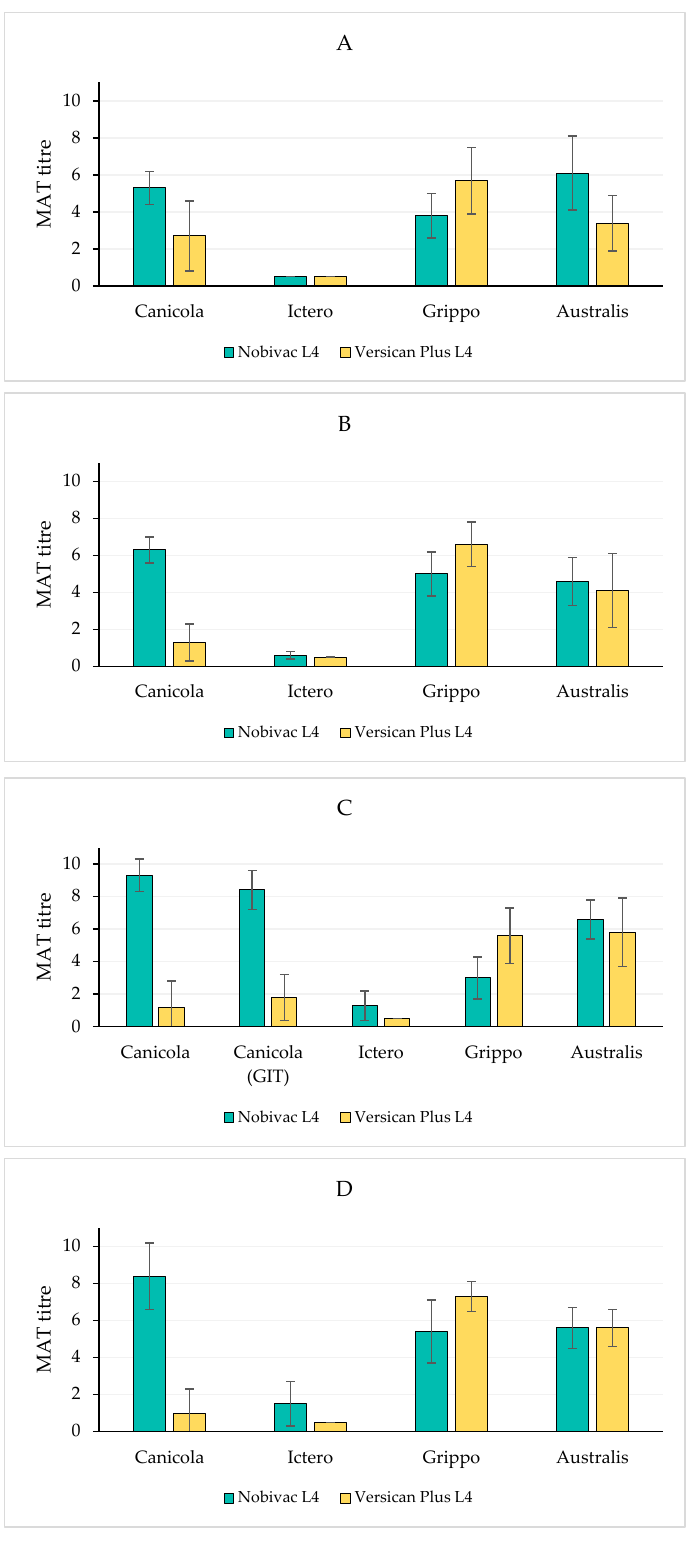
Figure 1. ( A ): Study 1, Grippotyphosa challenge; ( B ): Study 2, Icterohaemorrhagiae challenge; ( C ): Study 3, Canicola challenge; ( D ): Study 4, Australis challenge. Pre-challenge titres of agglutinating serum antibodies against the four vaccine serogroups in studies 1-4 and GIT titres against serogroup Canicola in study 3. MAT and GIT antibody titres three weeks after the second vaccination, expressed in log 2 values. Bars represent mean values and error bars represent standard deviations of the mean.